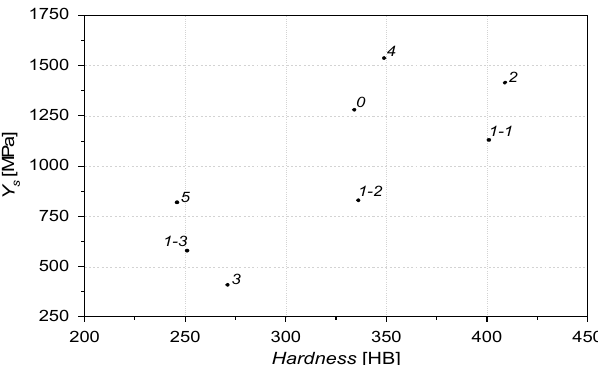
Figure 5. Correlation between yield strength and hardness of tested alloys .